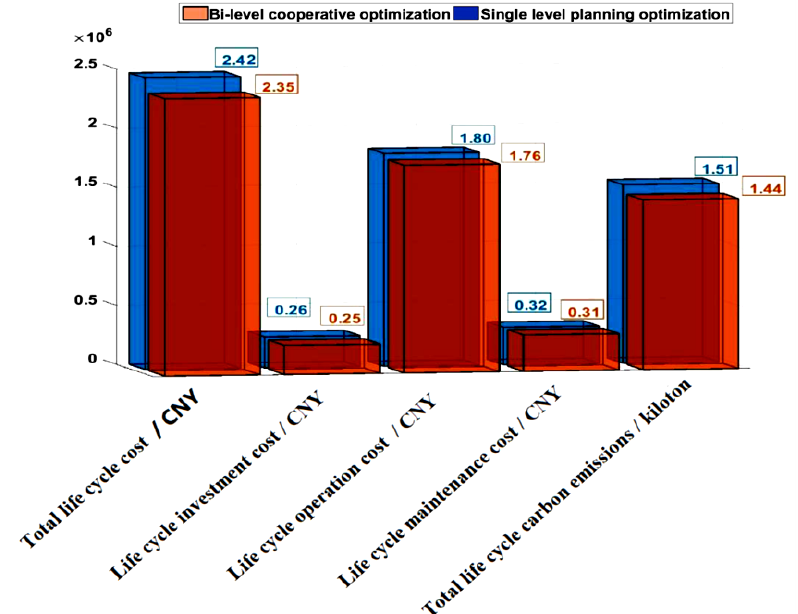
Figure 7. Comparison of objective cost and carbon emission vales under optimal solution